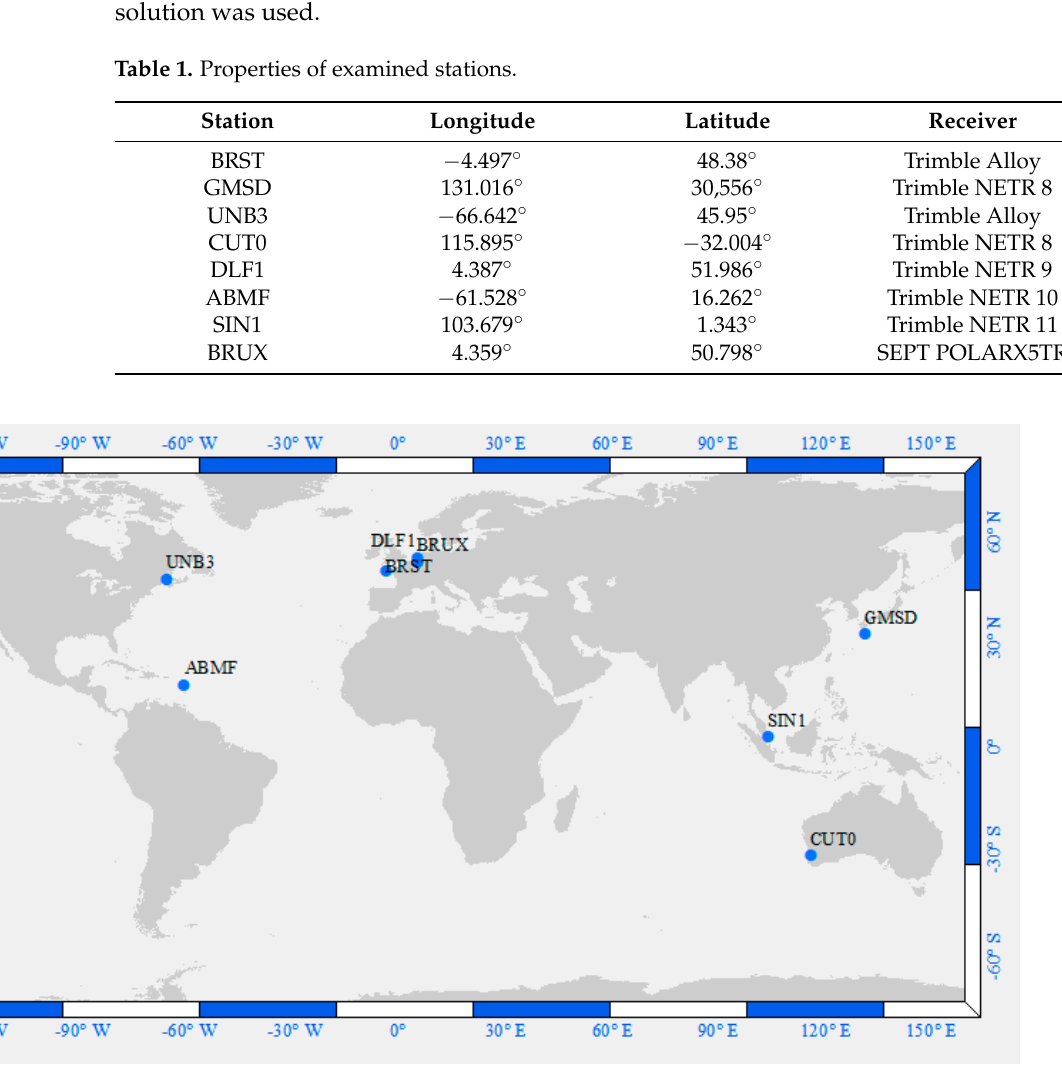
Figure 1. Distribution of the examined stations. Figure 1. Positioning errors for stations BRST ( left ) and CUT0 ( right ) using different GPS/Galileo PPP